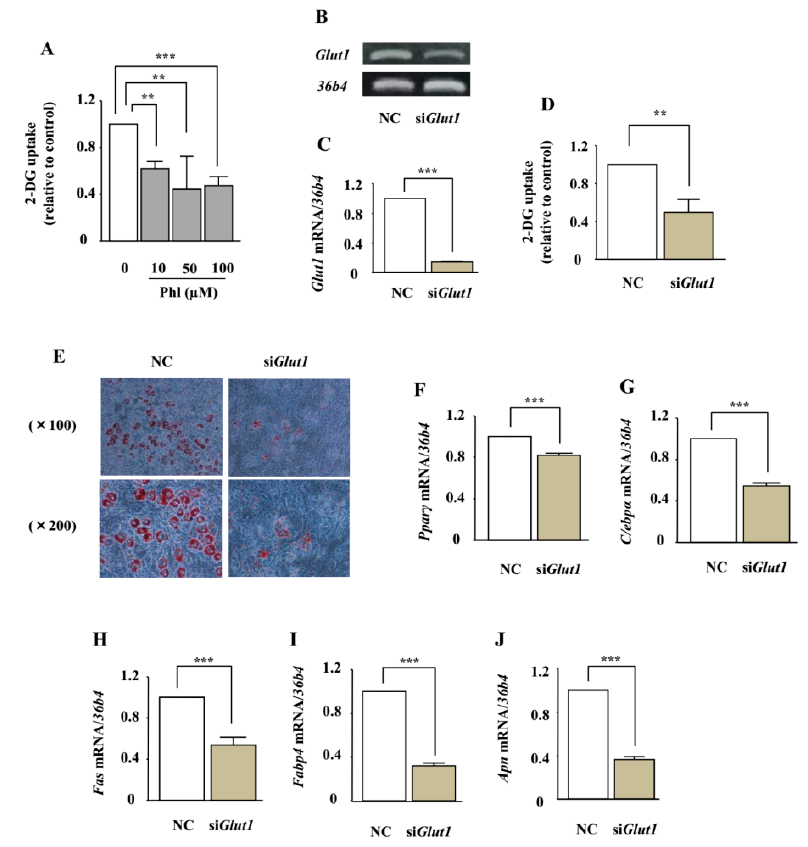
Figure 7. The role of glucose uptake inhibition in adipocyte differentiation in ST2 cells. ( A ) After